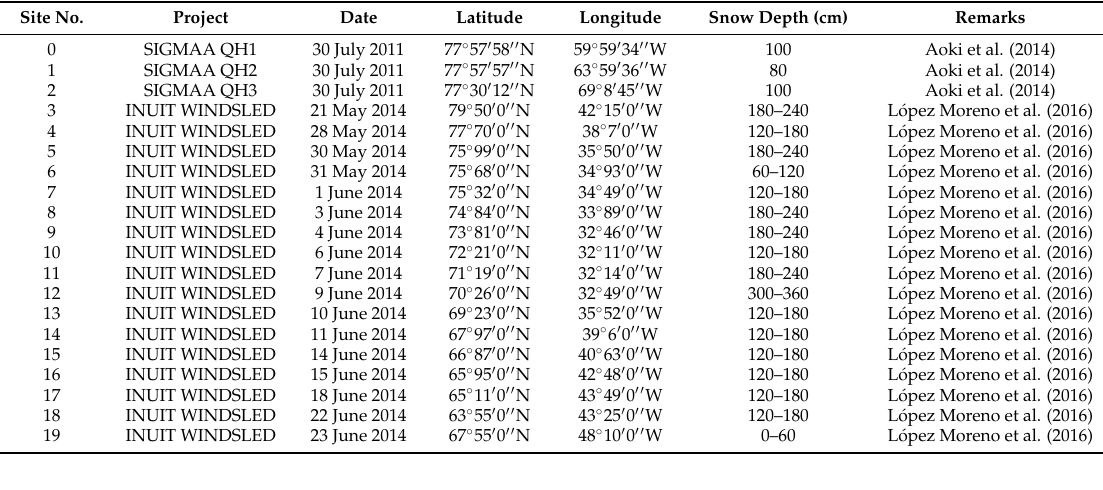
Table 1. Descriptions of field observation sites.